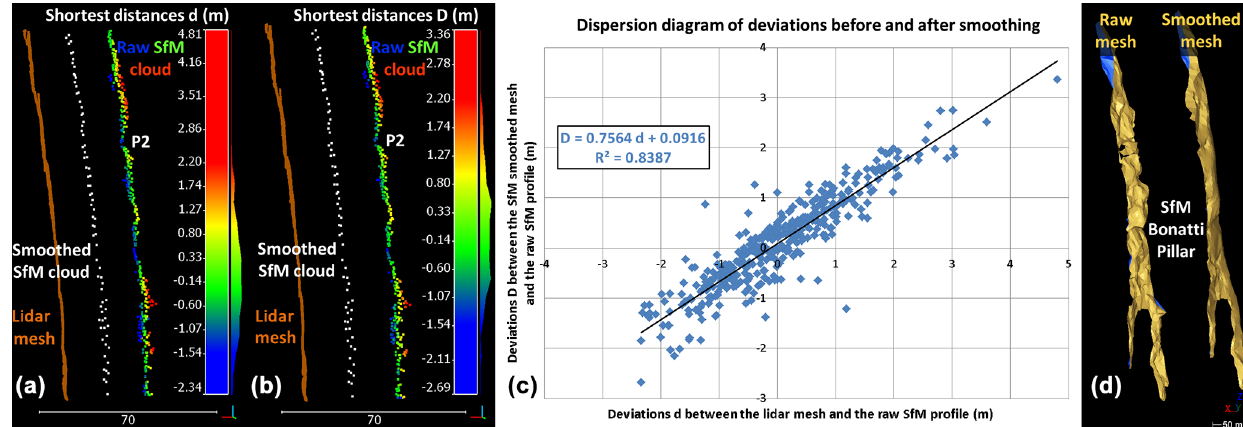
Figure 6. Smoothed data vs. raw data. (a) Result of the point-to-mesh comparison between the raw SfM profile P2 (colored points) and the reference lidar mesh (in brown). Same result as in Fig. 3f but with the subsample and smoothed SfM profile P2 (in white). The three entities were shifted in order to better display the differences between each profile. (b) Result of the point-to-mesh comparison between the raw SfM profile P2 (colored points) and the subsample and smoothed SfM profile P2 (in white). (c) Dispersion diagram characterizing the SfM point cloud smoothing procedure: minimization of large deviations and reduction of the average deviation by ± 0.76m. (d) Profile view of the raw and smoothed SfM meshes present in Fig. 5c and